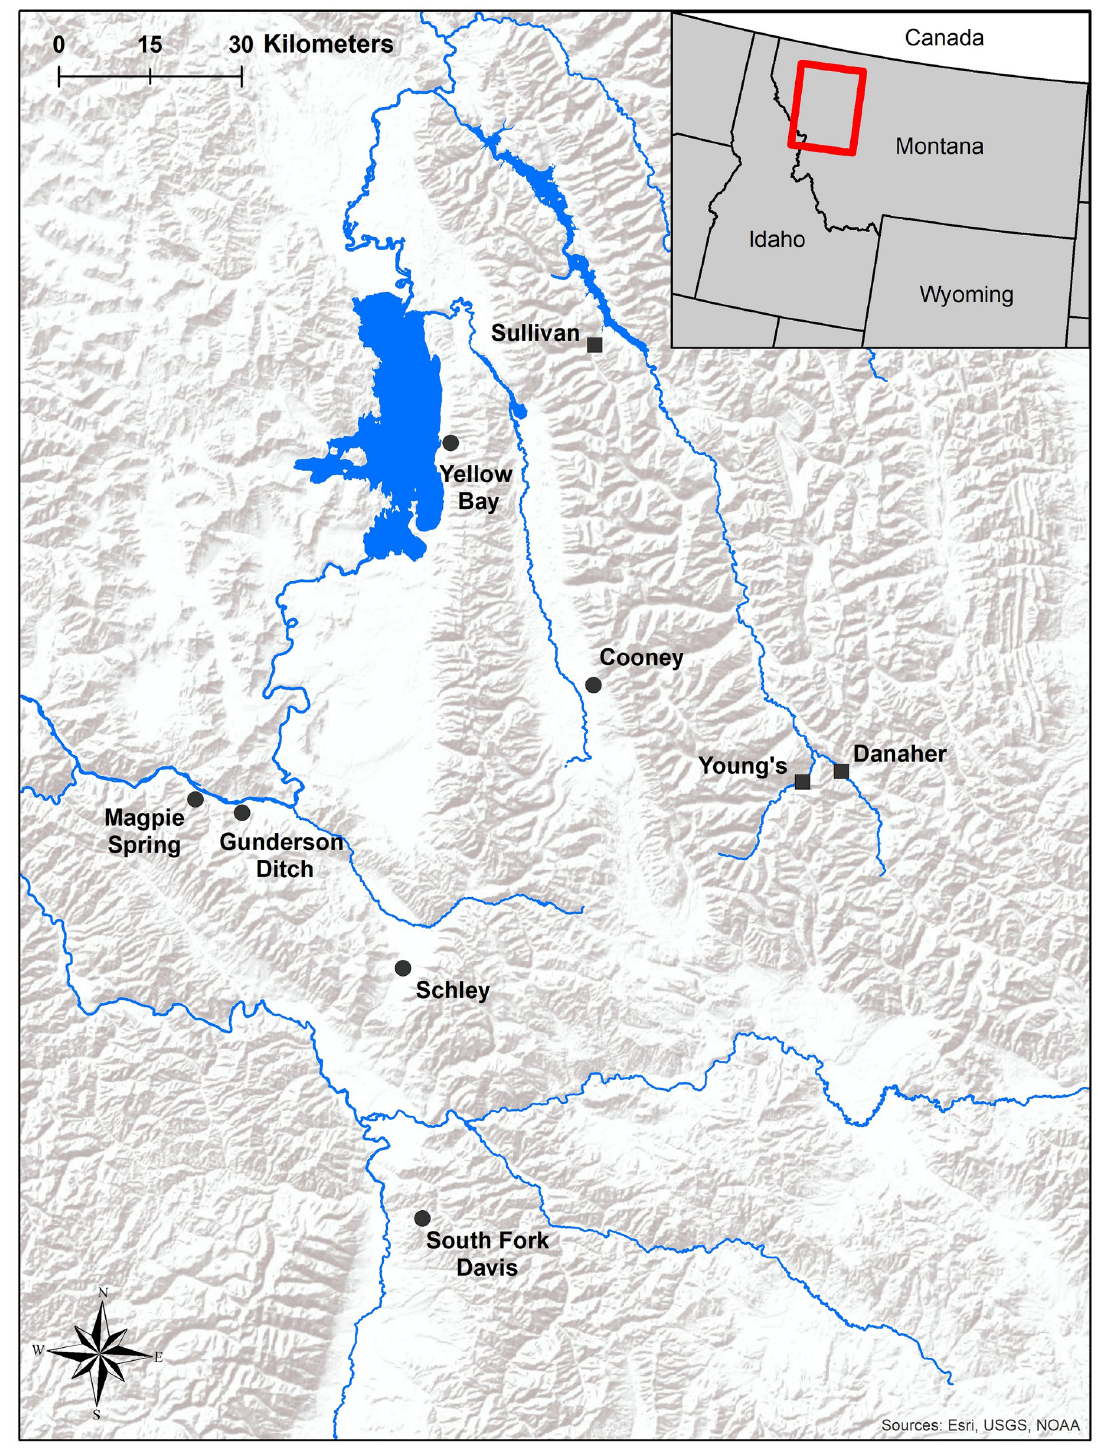
Fig 1. Locations of source populations for fish raised at Sekokini Spring Hatchery (squares) and wild resident populations (circles) surveyed in this study.